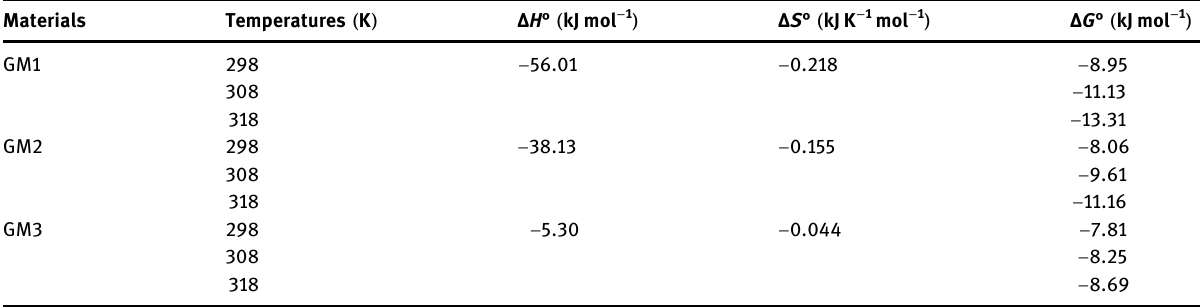
Table 3: Thermodynamic parameters of paracetamol adsorption on GM1, GM2, and GM3